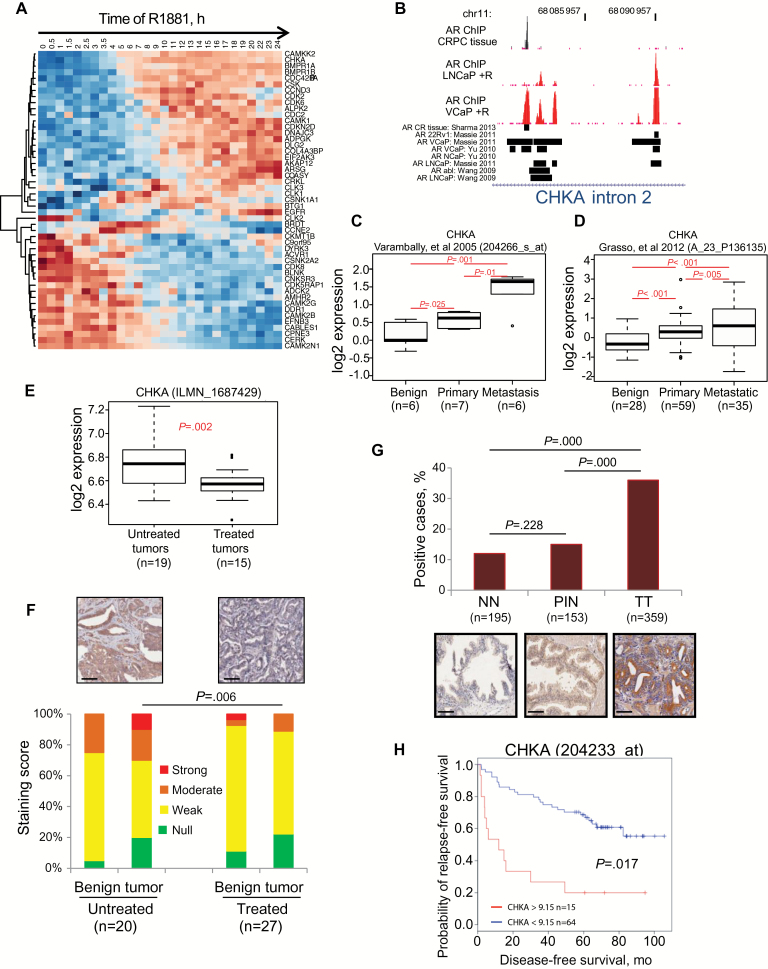
Identification of choline kinase alpha (CHKA) as a clinically relevant androgen receptor (AR) target in prostate cancer (PCa). A) Gene expression time course heatmap showing androgen regulation of kinases in LNCaP cells treated with 1nM R1881 androgen. Kinases identified as androgen-regulated on both Illumina beadarrays and SYBR Openarray Human Kinome panel are shown (values represent median centred Illumina beadarray). Blue color designates lower expression, and red indicates higher expression. B) Chromatin immuno-precipitation sequencing analyses from multiple studies on castration-resistant prostate cancer tissue and androgen (R1881)-stimulated PCa cell lines (8, 17, 62, 63) illustrating intron-2 of the genomic locus of the CHKA gene and AR binding sites (coordinates reference GRCh38). C-D) Boxplots show CHKA transcript expression in benign tissue, primary PCa, and metastatic PCa in two independent gene expression datasets (30,31). Boxplots show interquartile range (IQR), 95% confidence interval (CI), and outlier points. E) Boxplot showing CHKA transcript levels in tumors from PCa patients treated with the luteinizing hormone-releasing hormone analogue degarelix, compared with tissue from untreated control PCa patients of matched disease stage. Boxplots show IQR, 95% CI, and outlier points. F) Immuno-histochemical staining intensity score of CHKA protein expression in the benign adjacent epithelia (in duplicates) and the prostate tumors (in triplicates) of men seven days after treatment or no treatment with degarelix; P = .006 two-sided Wilcox rank-sum test of IHC intensity. Representative images inset above. Scale bar = 100 µm. G) Bar plots showing prevalence of CHKA human staining in non-neoplastic (NN; 195 case patients), prostate intraepithelial neoplasia (PIN; 153 case patients), and tumor tissue (TT; 359 case patients) as a percentage of total case patients. Representative images inset below. Scale bar =100 µm. H) Kaplan-Meier survival curve from recursive partitioning analysis showing that high CHKA transcript levels are associated with poor recurrence-free survival in the Glinsky cohort (P = .017) (27). AR = androgen receptor; CHKA = choline kinase alpha; CI = confidence interval; CRPC = castration-resistant prostate cancer; IQR = interquartile range; LHRH = luteinizing hormone-releasing hormone; R = R1881.